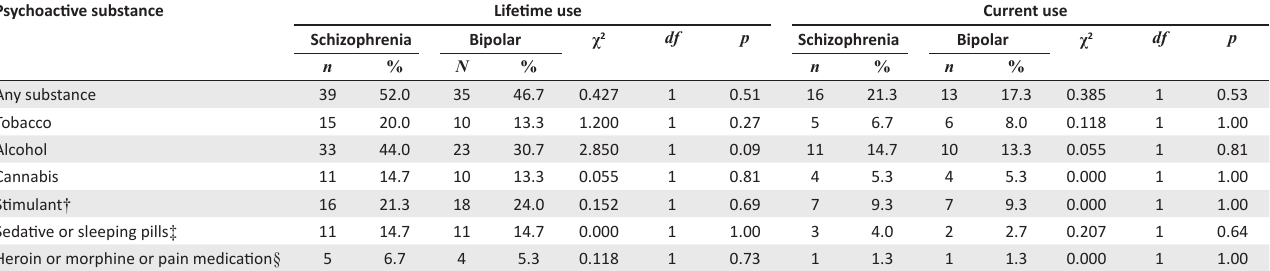
TABLE 2: Comparison of current and lifetime prevalence of psychoactive substance use among patients with schizophrenia ( n = 75) and bipolar affective disorder ( n = 75). Psychoactive substance